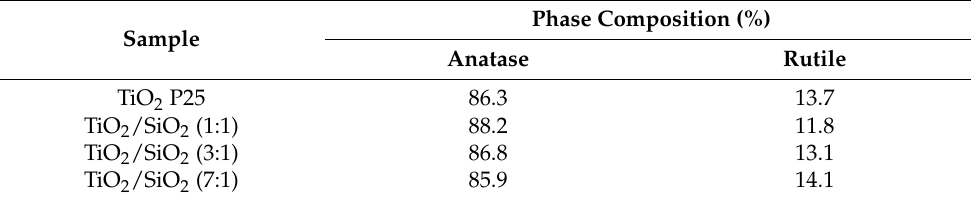
Figure 1. X-ray diffraction pattern of ( a ) TiO 2 P25, ( b ) TiO 2 /SiO 2 composite 1:1 ratio, ( c ) TiO 2 /SiO 2 composite 3:1 ratio, and ( d ) TiO 2 /SiO 2 composite 7:1 ratio. Table 1. Percentage of phase composition of the